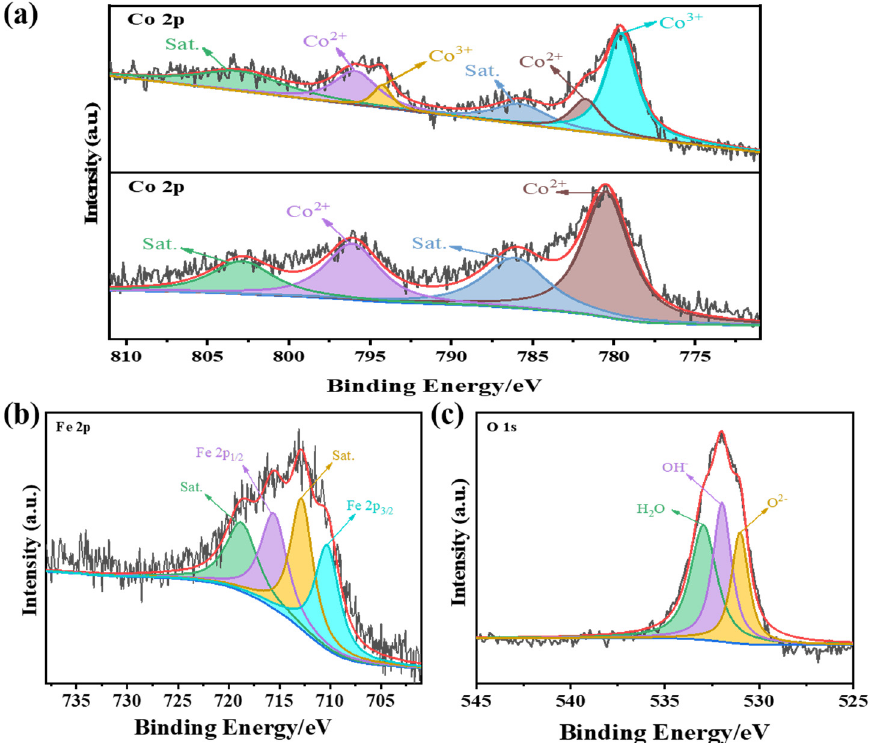
Figure 4. High-resolution XPS spectra of CoFe-LDH@Co-ZIF@CC: ( a ) Co 2p, ( b ) Fe 2p and ( c ) O 1s,